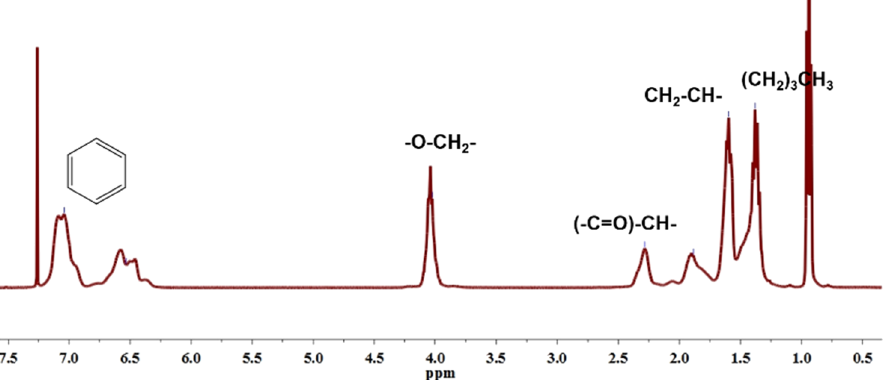
Figure A1: 1 H NMR of the synthesized three - arm star polystyrene - block -( n - butylacrylate ) copolymer ( S x - b - B y ) 3 with CDCl 3 as the solvent.